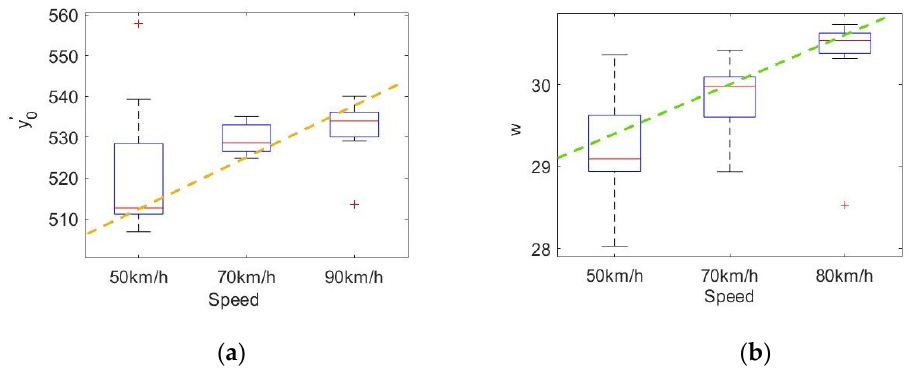
Figure 11. Relationship between fitting parameters and vehicle speed on straight lane: ( a ) relationship between velocity and y (cid:48) and ( b ) relationship between velocity and w .